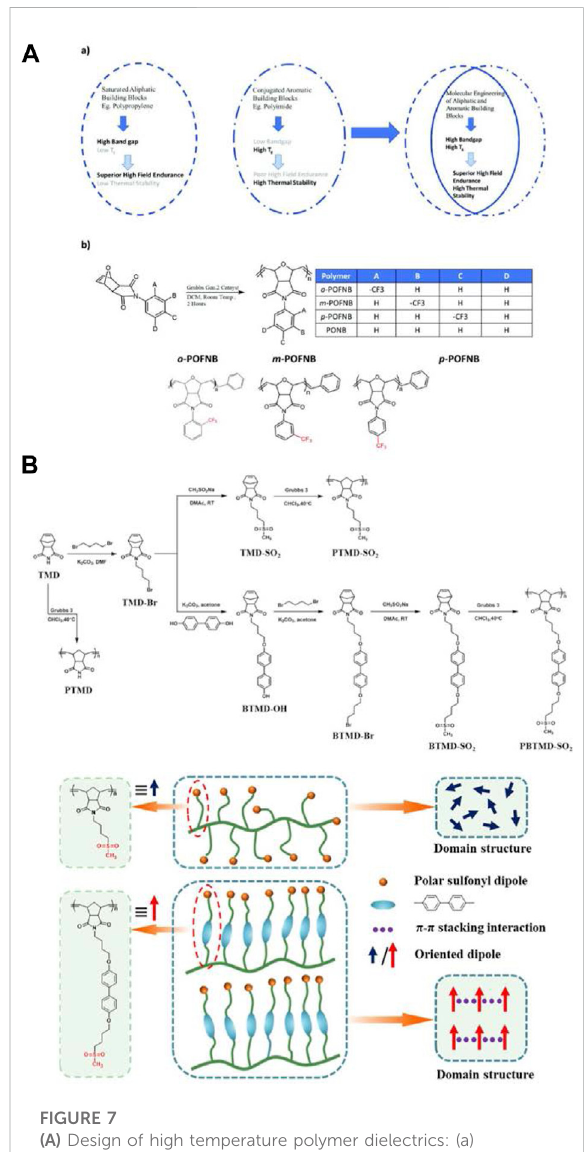
FIGURE 7 (A) Design of high temperature polymer dielectrics: (a) Conceptual schematic for design of high temperature dielectric polymers; (b) Molecular structures of polymers investigated in this work; (B) Procedure for the synthesis of monomers and polymers, and schematic illustration of the effect of biphenyl groups on the dielectric properties of polymers. Reproduced with permission from Ref. 76 and 77. Copyright 2022 and 2011 The Royal Society of Chemistry and American Chemical